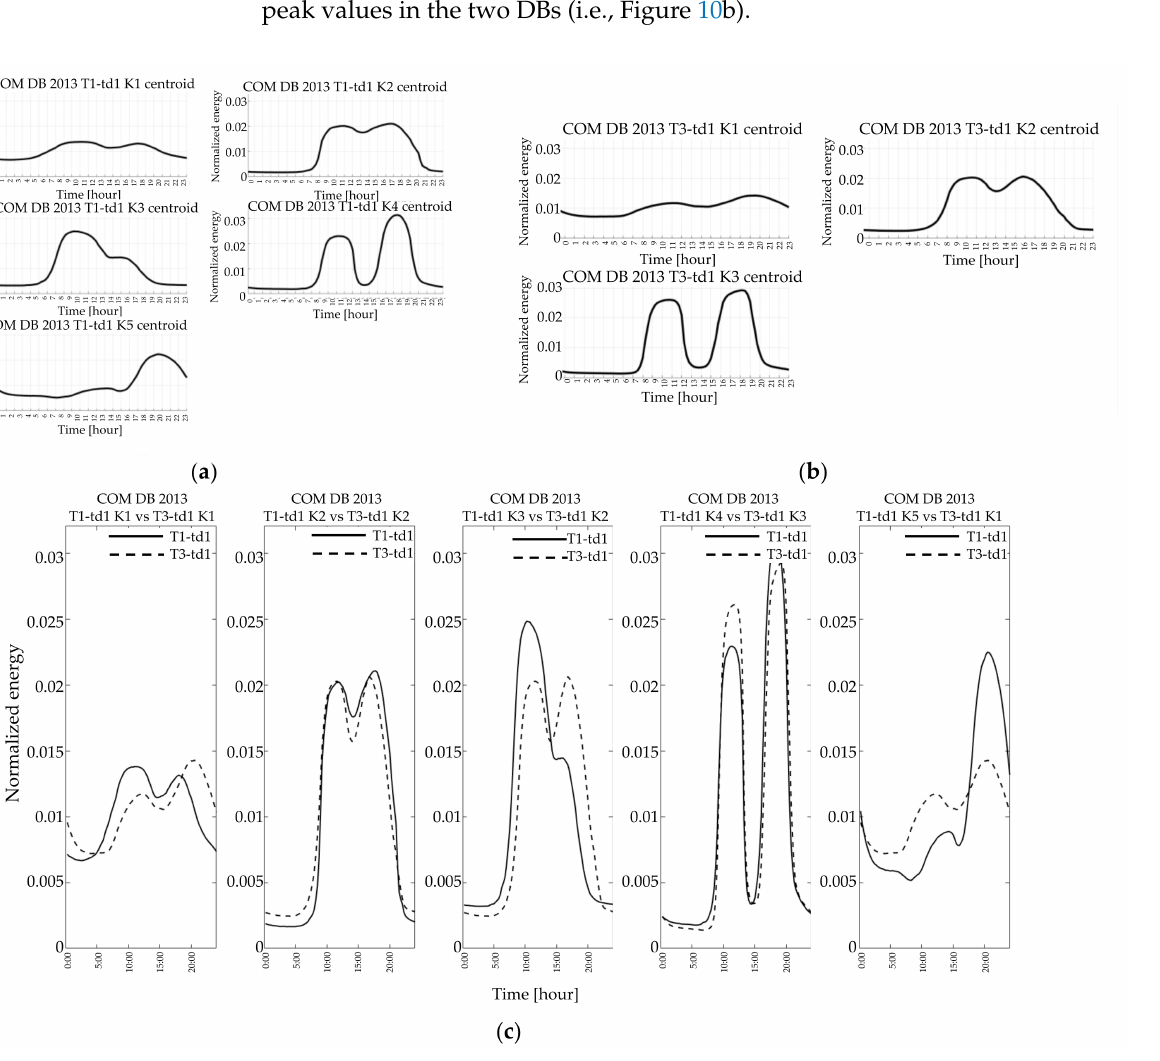
Figure 8. Database 2013, commercial (COM) end-users, normalized centroids: ( a ) winter workdays (five clusters), ( b ) summer workdays (three clusters), ( c ) comparison between the two typical